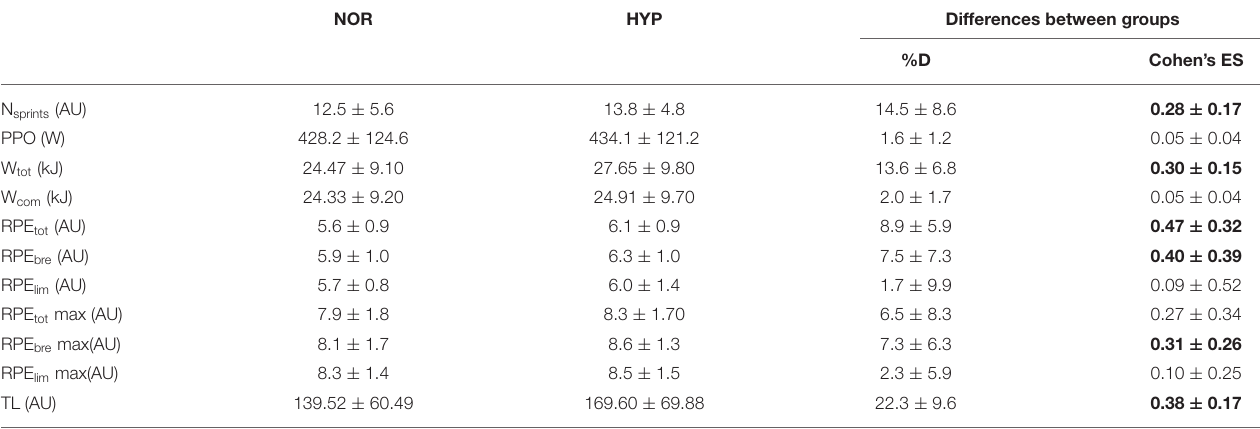
TABLE 1 | Mean changes in performance and perceptual exercise responses in the repeated-sprint ability test in normoxia (NOR, F I O 2 : 0.21) or hyperoxia (HYP, F I O 2 : 0.40). NOR HYP Differences between groups %D Cohen’s